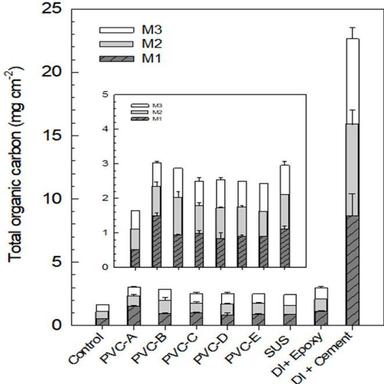
Total organic carbon migration potential of the selected pipe materials at 25 ◦C. M1, M2, and M3 represent three test cycles (3 d per cycle). The tests were conducted in duplicates. The error bars indicate standard deviation.